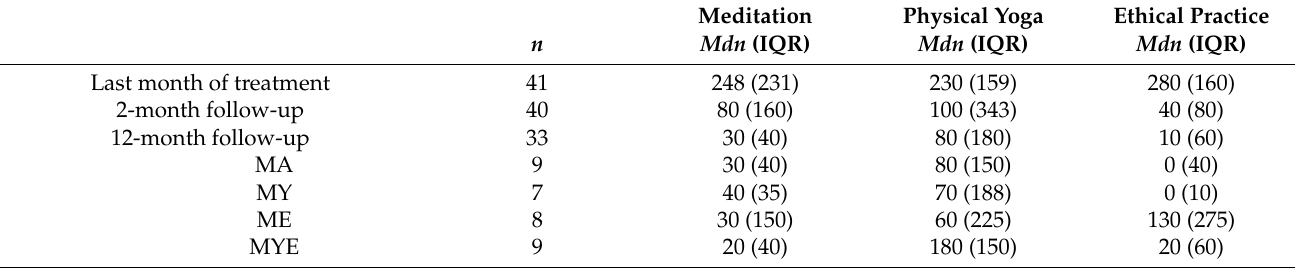
Table 1. Accumulated monthly practice of meditation, physical yoga, and ethical practice in minutes for the last month of the treatment, the 2- and 12-month follow-up, and the 12-month follow-up in each condition. Meditation Physical Yoga Ethical